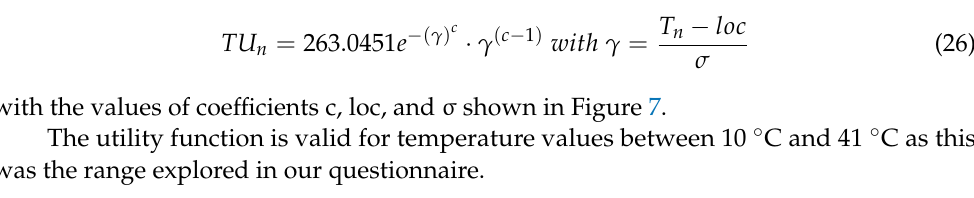
Figure 8. Percentage of respondents considering a rainfall duration as ideal (green line) and unacceptable (red line).